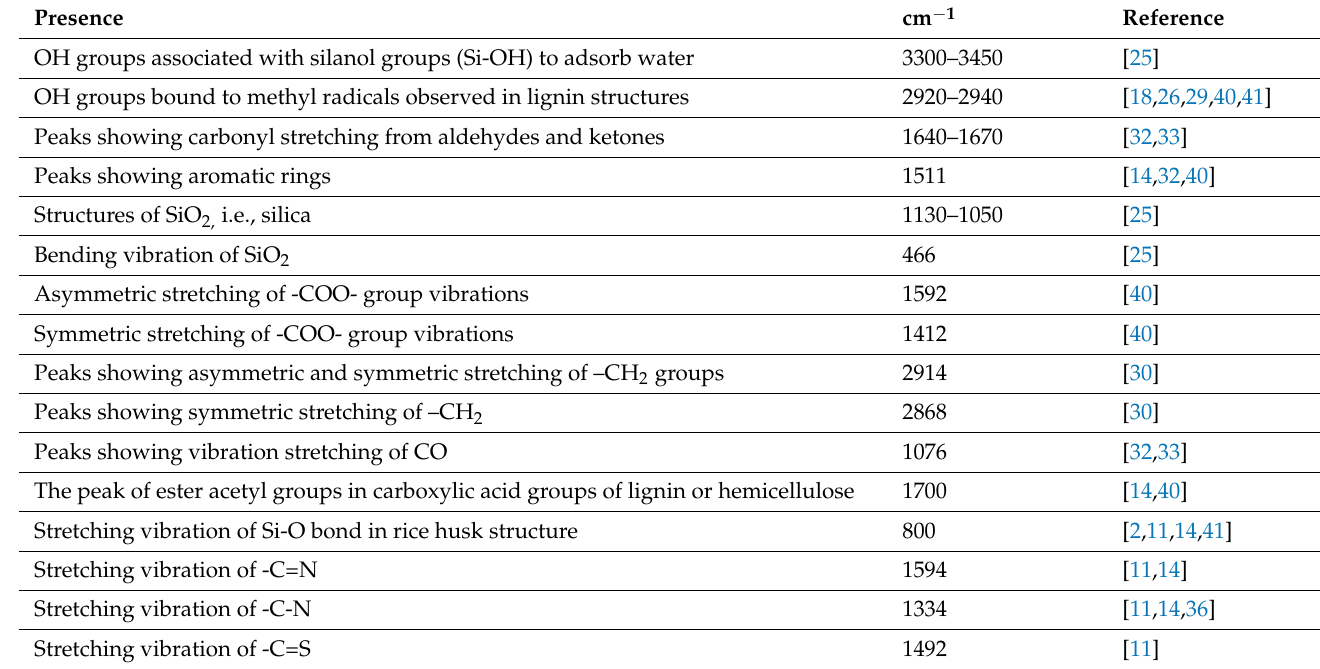
Table 2. The functional groups of varieties of agricultural waste containing